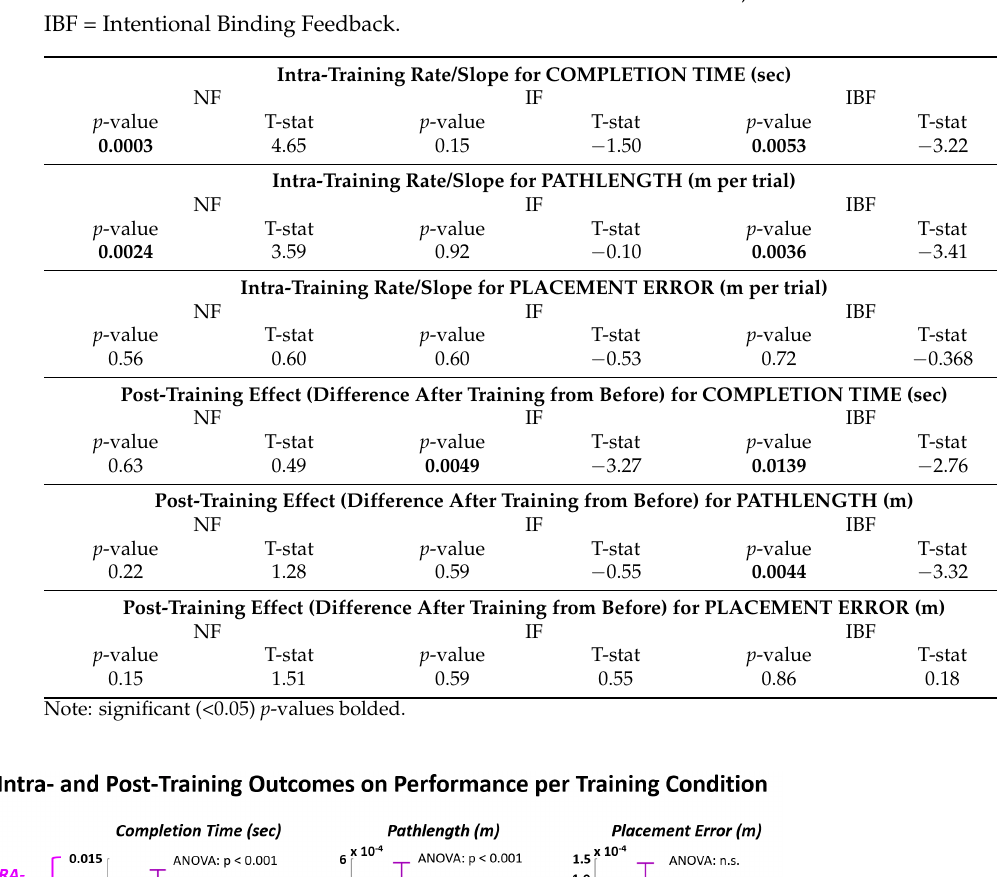
Table 5. One-sample t-test results to confirm if intra- and post-training outcomes on perfor-